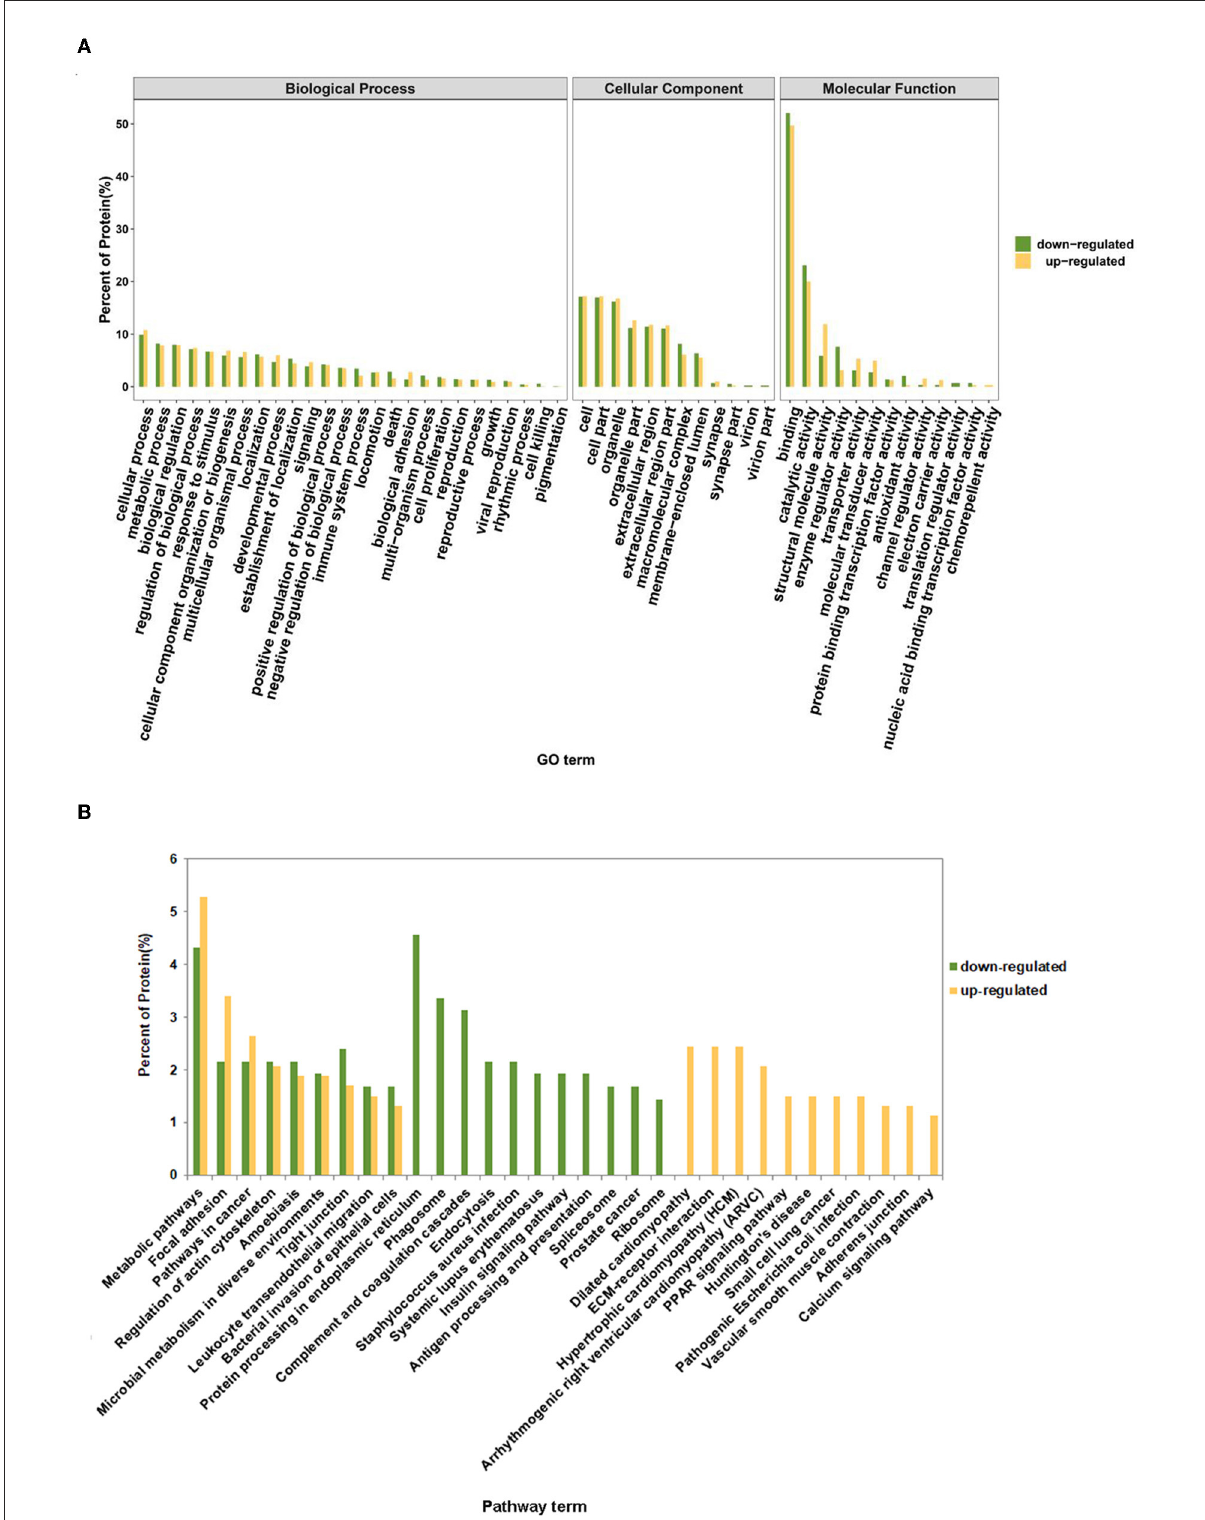
FIGURE3 GO and KEGG annotation analysis of up-regulated and down-regulated proteins. (A) The percentage of up-regulated and down-regulated proteins in each GO term. (B) The percentage of up-regulated and down-regulated proteins in the top 20 annotated KEGG pathway terms.